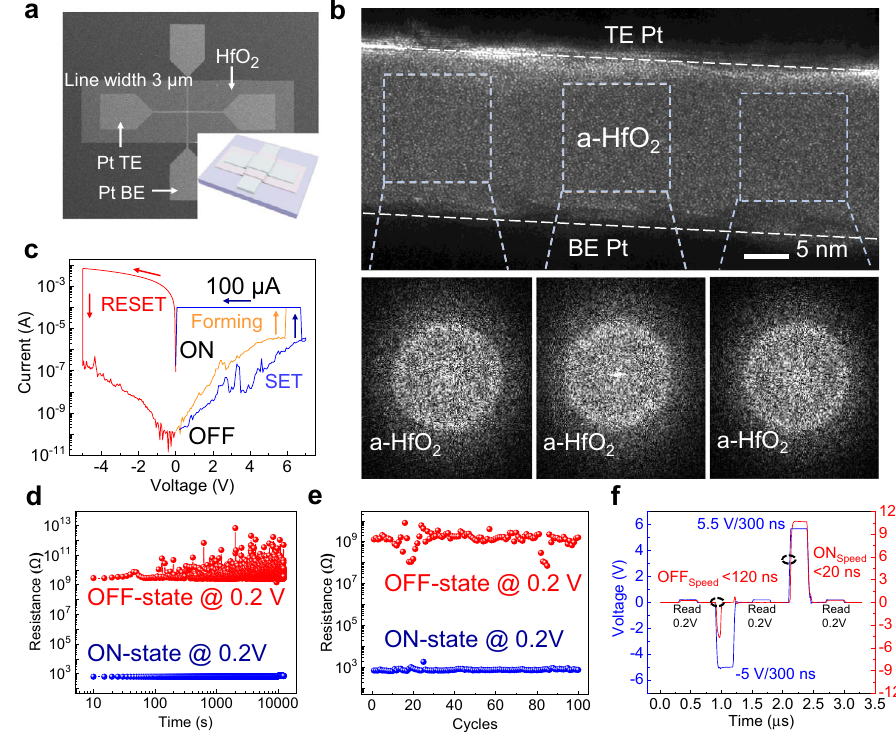
Fig. 1 Structure and RS performance of the Pt/HfO 2 /Pt memristor. a SEM image and schematic illustration of the Pt/HfO 2 /Pt memristor. The effective line width of the memristor is 3 μ m. b HRTEM image of the fresh Pt/HfO 2 /Pt stack and the typical FFT diffraction patterns of the marked region of the HfO 2 RS layer, indicating the amorphous morphology of the as-fabricated HfO 2 fi lm. c Typical RS I – V characteristics of the device. d Retention characteristics of the HRS and LRS of the device for 10 4 s. e The resistance distribution of HRS and LRS of 100 switching cycles from the 10 randomly selected devices. f Typical V - t and I – t synchronous curves of the OFF and ON switching processes under the pulse mode, where both the LRS and the HRS can be reversed to their opposites within a 300 ns write or erase